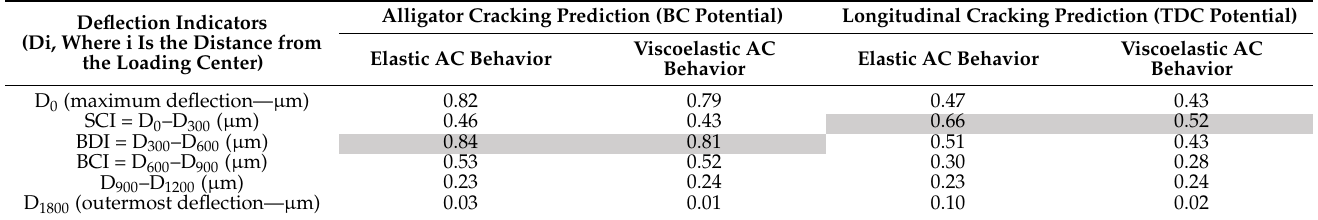
Table 4. Correlations (values of R 2 ) between deflection indicators and predicted fatigue